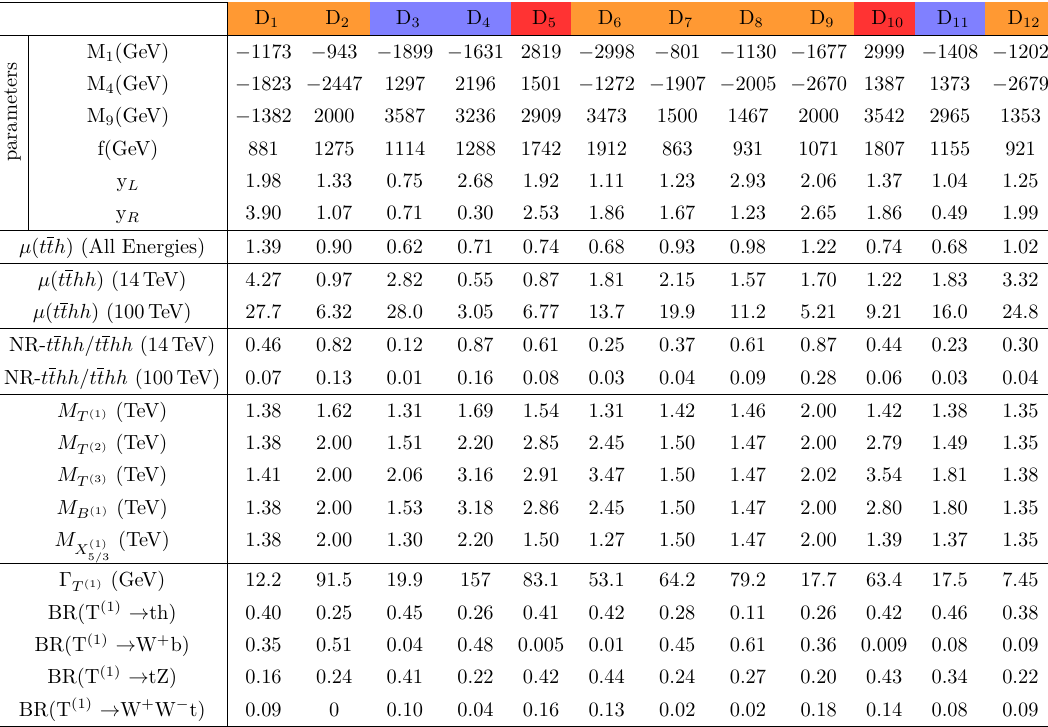
Table 6 . Benchmark points for the low scale MCHM 14 scan and their main features. Column headings indicate region, with red and orange meaning respectively Regions I and III (with same sign M 1 and M 4 ) and blue and cyan respectively for regions II and IV (with opposite sign M 1 and M 4